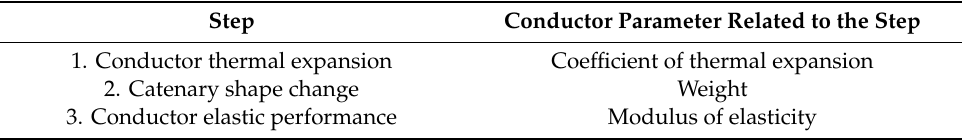
Table 1. Conductor parameters that affect the thermal expansion process.